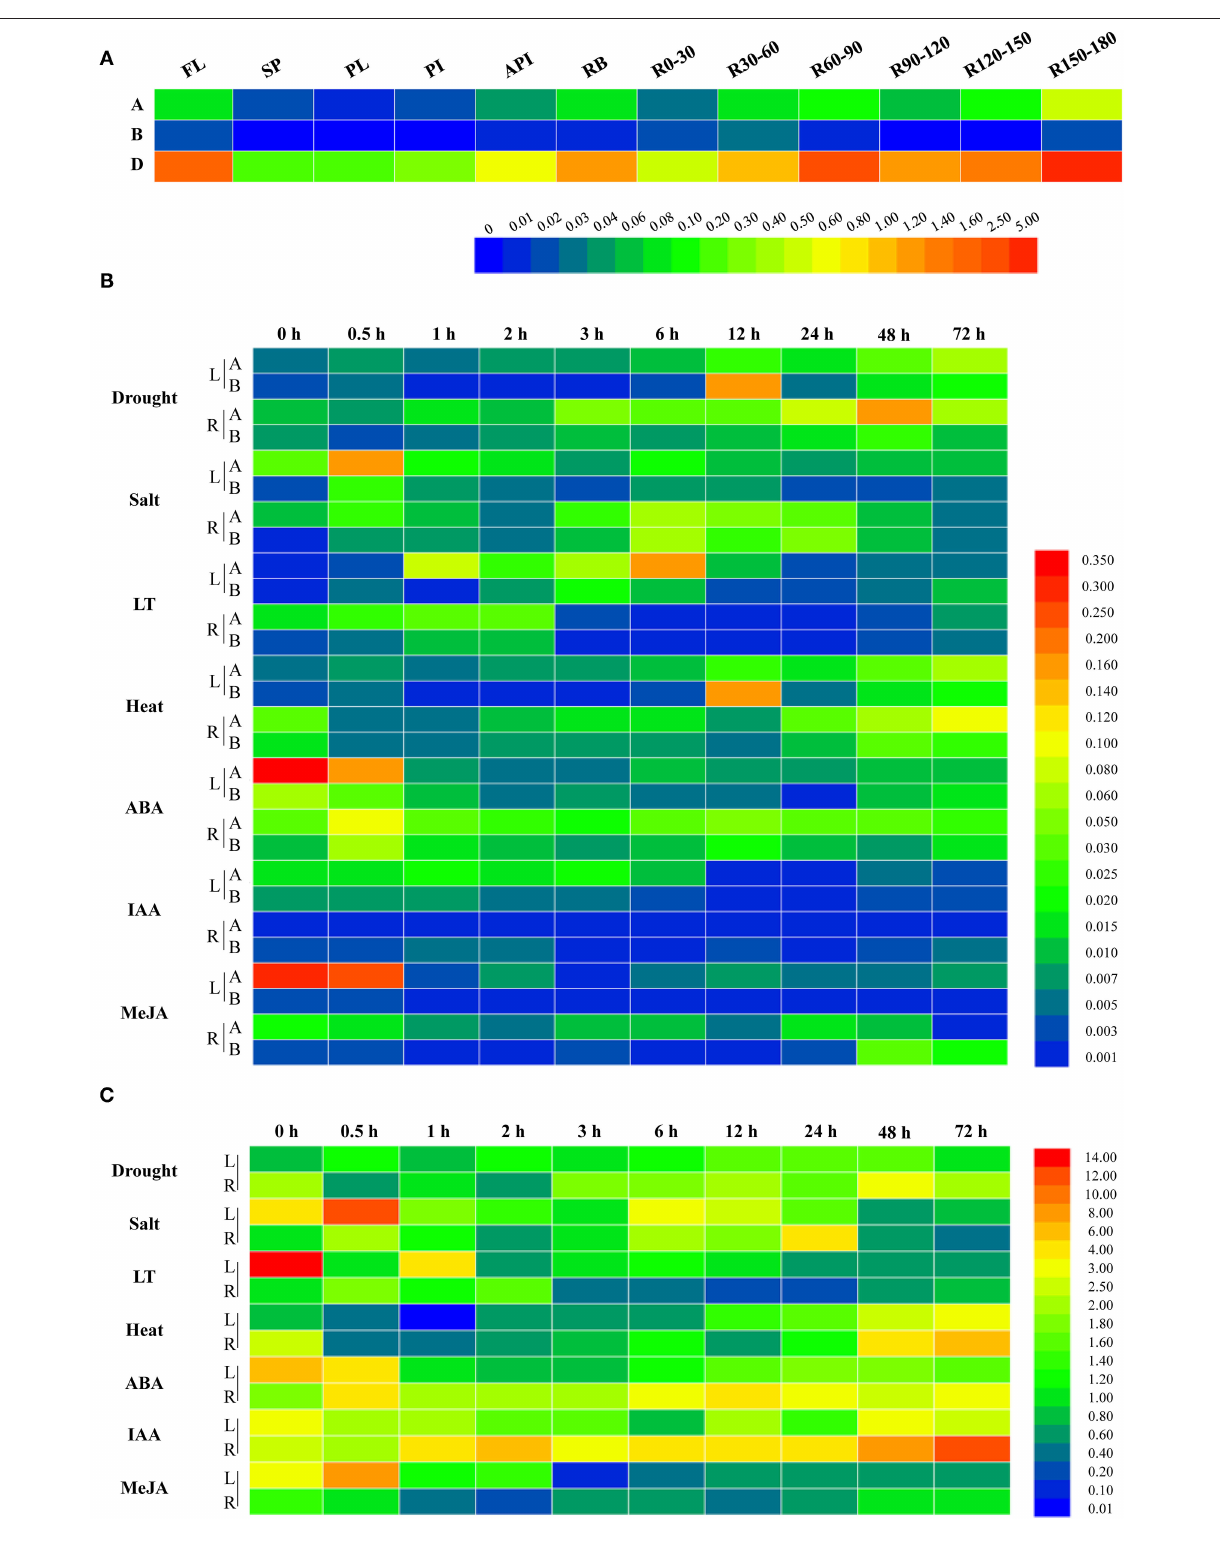
FIGURE 2 | Expression patterns for TaWRKY51s in different tissues and under various abiotic stress and phytohormone conditions. (A) The tissue specific expressions of TaWRKY51s at the flowering stage in wheat. The relative expression levels of TaWRKY51-2A and -2B (B) and TaWRKY51-2D (C) in the wheat leaves and roots under various abiotic stress conditions and upon different phytohormones. A TaWRKY51-2A ; B TaWRKY51-2B ; API, antepenultimate internode; FL, flag leaf; L, leaf; LT, low temperature; PI, penultimate internode; PL, peduncle length; SP, spike; R, root; Rx-y, indicates the root section from x to y centimeters.